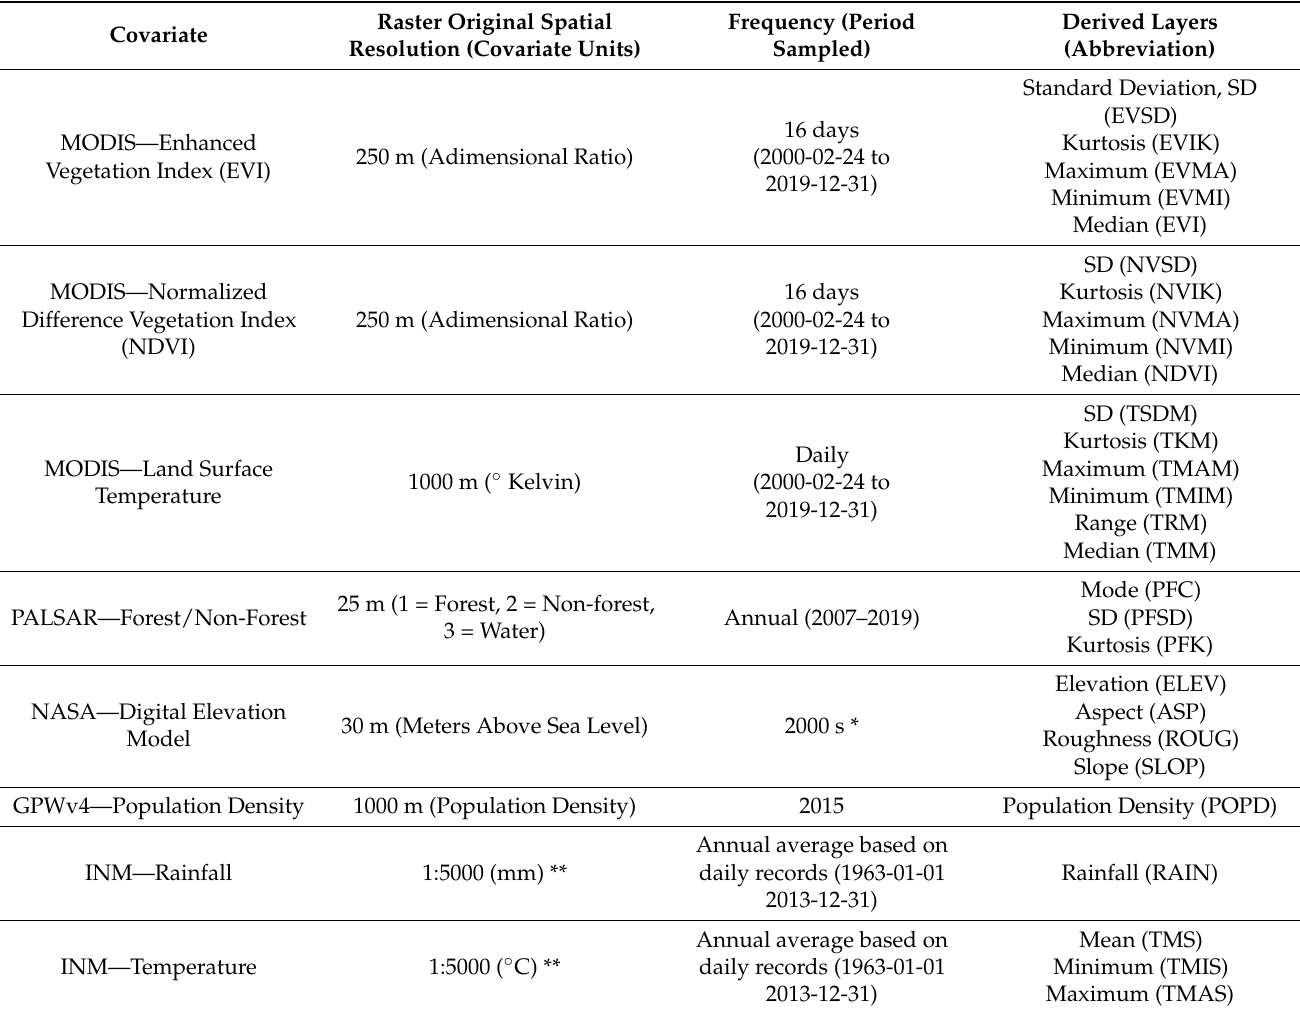
Table 1. Environmental covariates considered for Anopheles albimanus species distribution modeling in Costa Rica. * Geological feature, ** vector